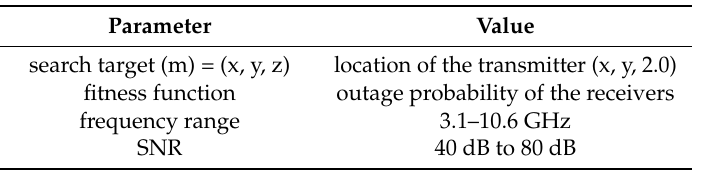
Table 1. Simulation setup.